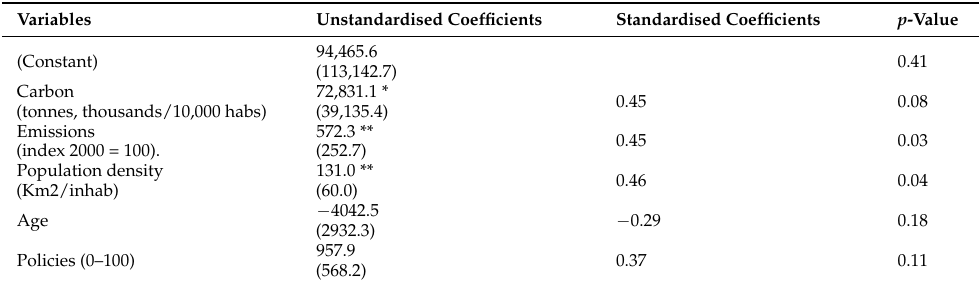
Table 2. Multiple regression